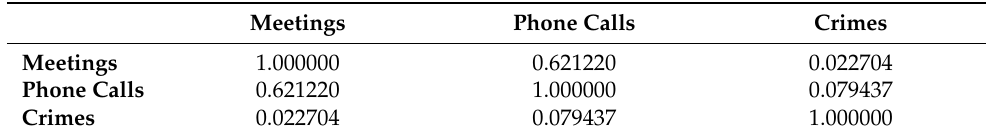
Table 7. Pearson layer correlation in the Montagna multiplex network.